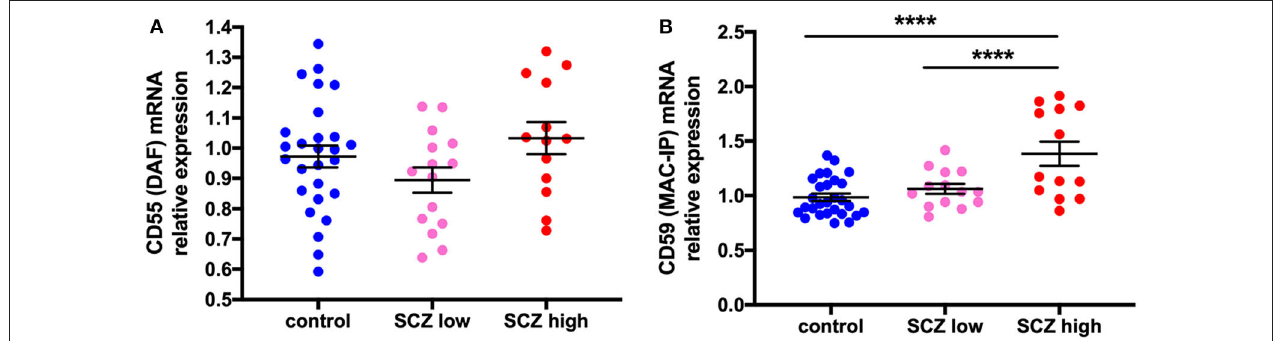
FIGURE 6 | Complement regulator CD59 mRNA, but not CD55 mRNA, is increased in schizophrenia cases with a high inflammatory biotype. (A) DAF mRNA was unchanged when analyzed by inflammatory subgroup ( F = 2.06, df = 52,2, p = 0.14). (B) In contrast, MAC-IP mRNA was increased when analyzed by inflammatory subgroup ( F = 16.04, df = 51,2, p < 0.0001). Data are mean ± SEM, **** p < 0.0001.